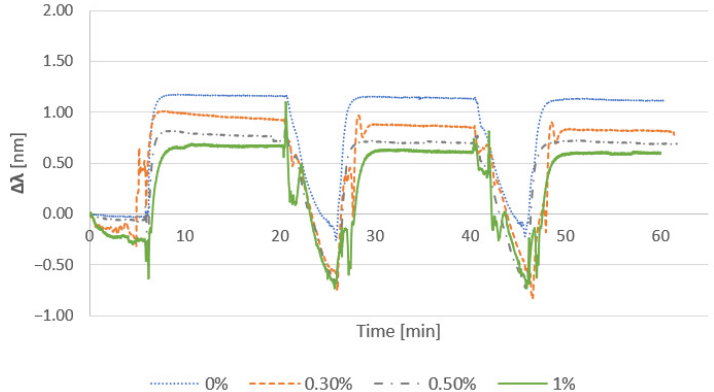
Figure 5. NPS signal as a function of time for samples formulated with SLES/CAPB 12 wt. % and different levels of salt at room temperature and pH ~7.